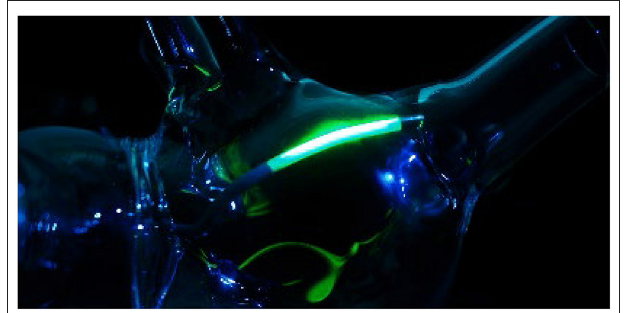
FIGURE 1 | Visualization of the laser active area by use of a low energy green laser diode, depicting the linear lateral emission of the catheter.